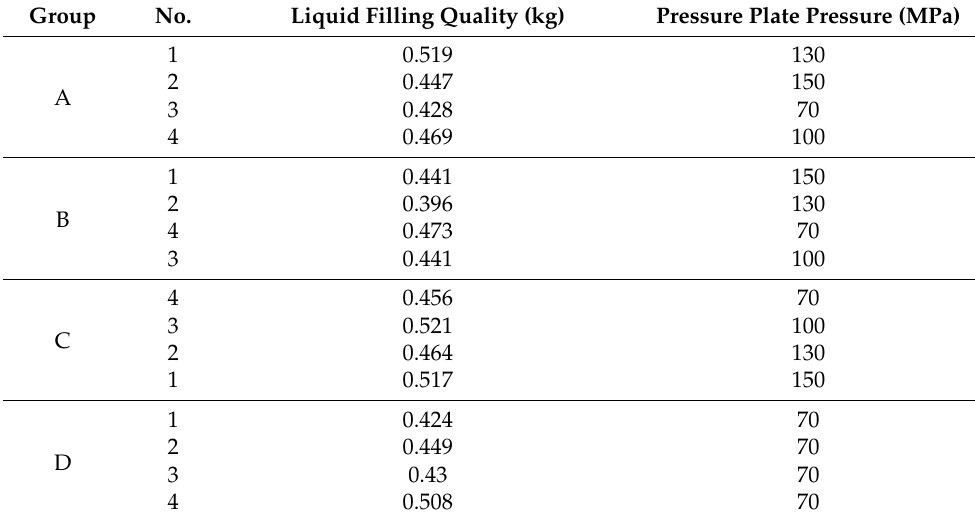
Figure 3. Schematic diagram of the CO 2 blasting tube structure. Table 4. Carbon dioxide charge quality.